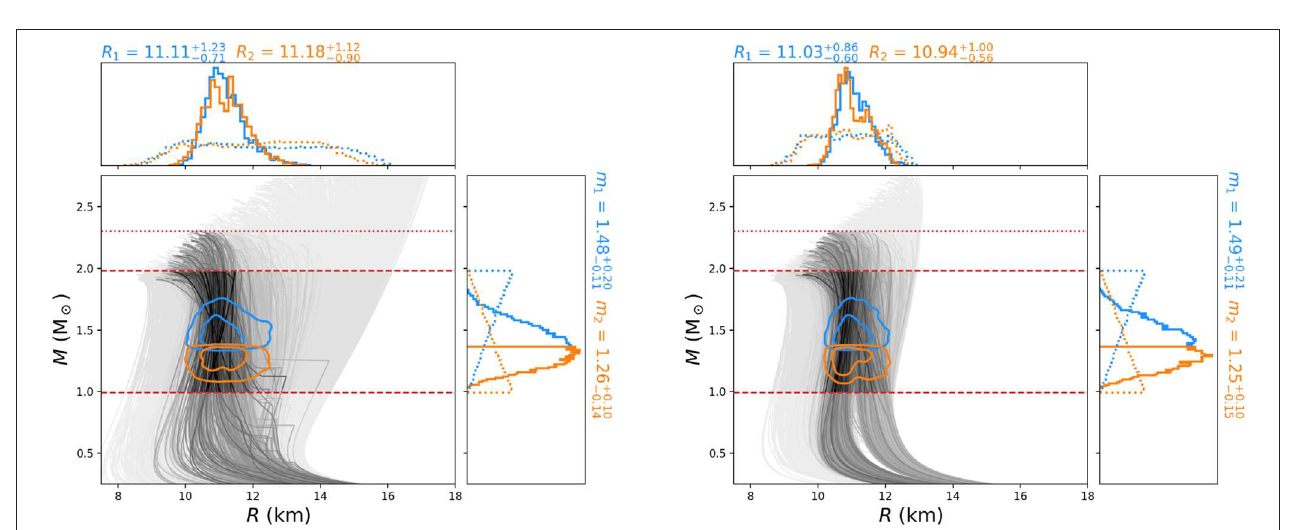
n sat (left) and n tr 2 n sat = =